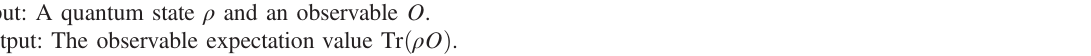
TABLE I. Protocol for extracting the expectation value of an arbitrary observable O . The “ experiment ” and “ precomputation ” steps can be done independently, the “ data-processing ” step uses both inputs to estimate Tr ð ρ O Þ . Input: A quantum state ρ and an observable O